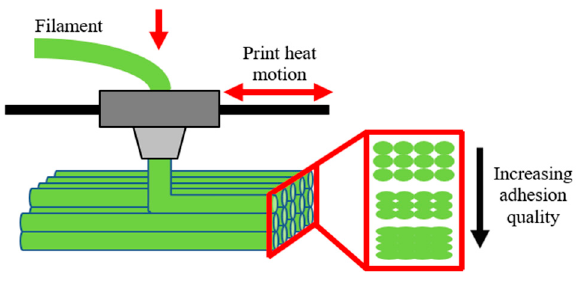
Figure 1. Schematic illustration of the adhesion quality importance during FDM.